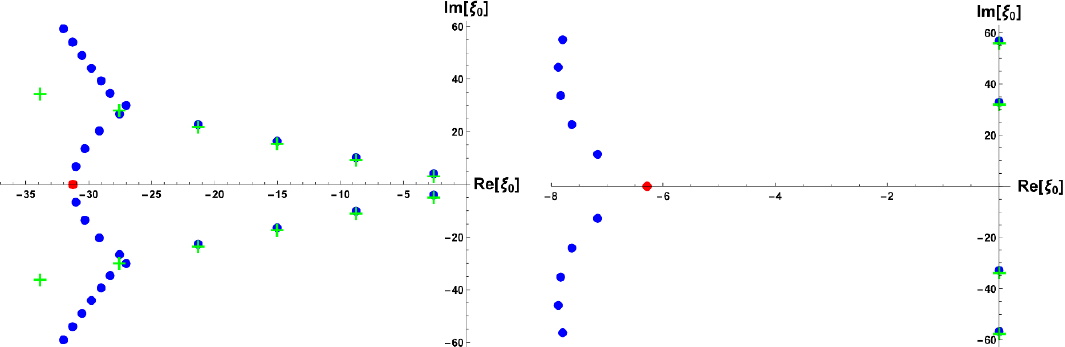
JHEP03(2019)146 for wide (cid:1)=2